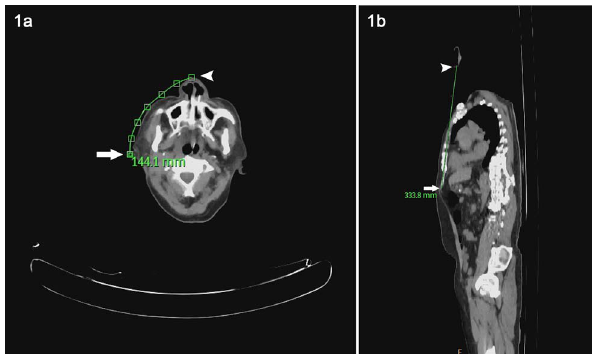
Figure 1. a. The curved length of Nose-Ear (NE) was measured from the nostril (Arrow) to the lobule of auricle (Arrowhead) by tracing five more points along the face surface between the two ends. b. The linear Ear- Xiphoid (EX) length is measured from the ear lobe (Arrow) to the lower tip of xiphoid